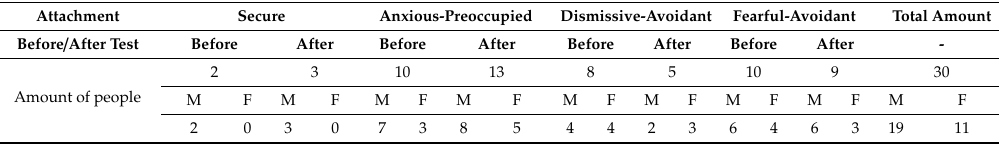
Table 4. Pre- and post-analysis of attachment styles.